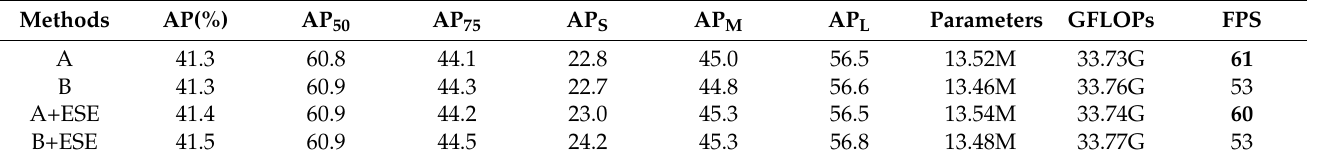
Table 2. Table of comparison experiments between the two operations. “A” represents the cheap op- eration, “B” represents the expensive operation and ESE is the channel attention mechanism